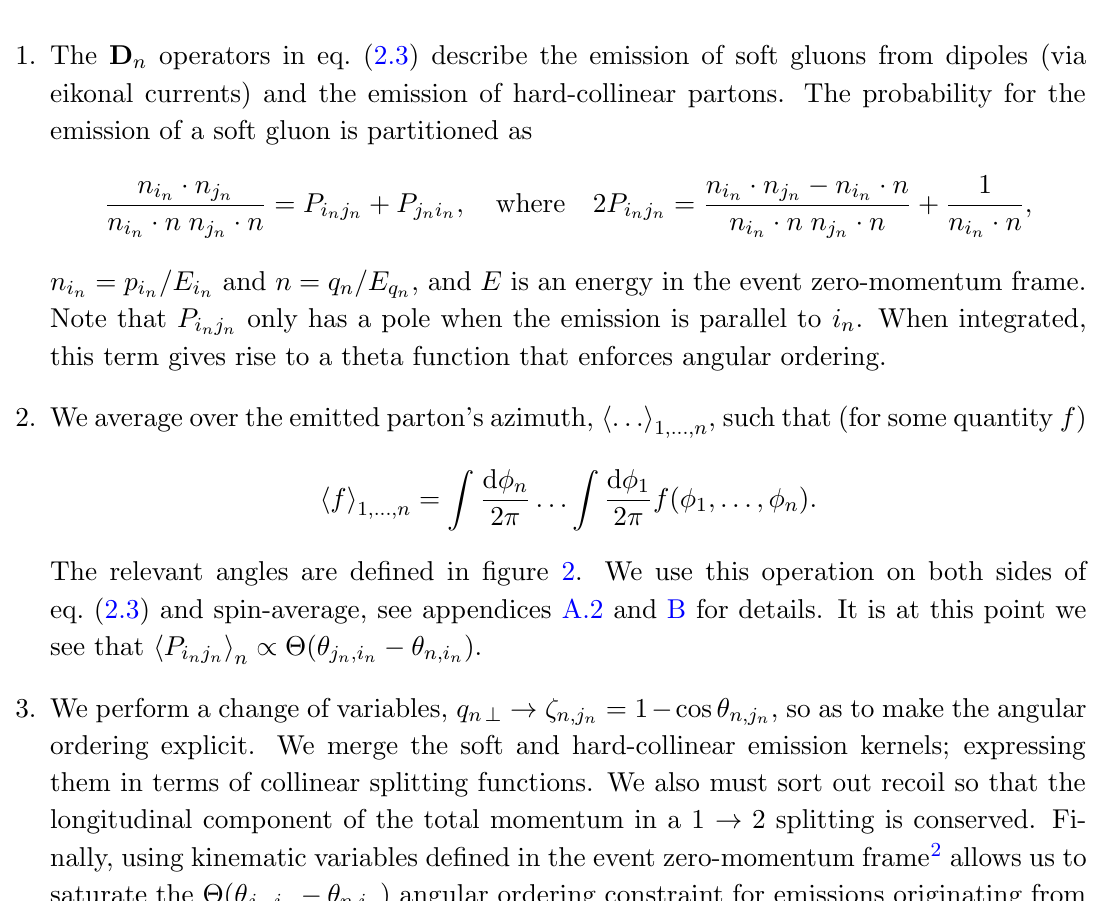
> (cid:18) n;j n ;j n n